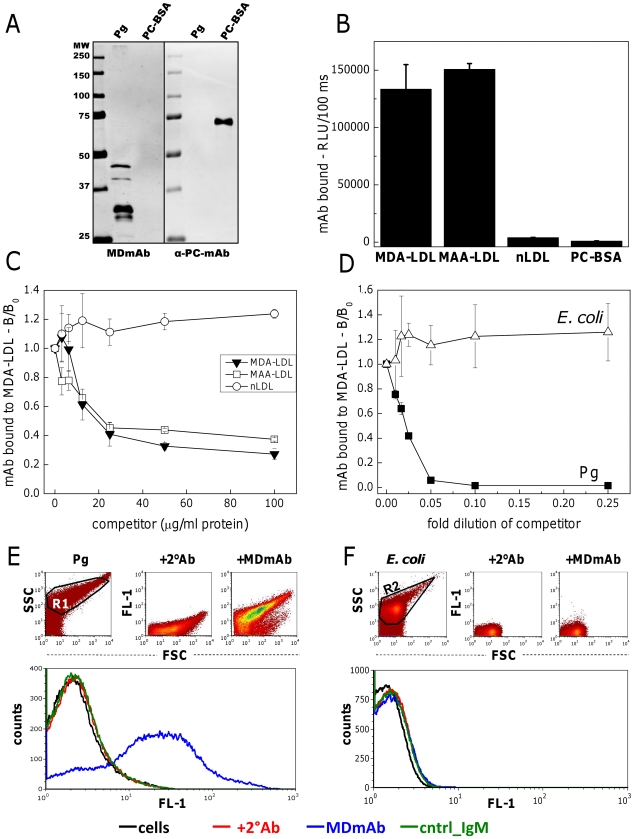
Cross-reactive epitopes on MDA-LDL and bacteria.Binding of anti-MDA-LDL-IgM (MDmAb) and anti-PC-IgM control antibody (α-PC-mAb) to P. gingivalis (Pg) and PC-conjugated bovine serum albumin (PC-BSA) on Western blot (A). Binding of MDmAb to MDA- and MAA-modified and native LDL (nLDL) and PC-BSA using direct binding (B) and competitive (C) chemiluminescence immunoassays. Specific binding of MDmAb to P. gingivalis (Pg) and E. coli was tested with competitive chemiluminescence immunoassay (D). Bacterial suspensions were adjusted to an absorbance of 0.15 at 580 nm with PBS and further diluted as indicated. B/B0 indicates the ratio of IgM binding with and without a competitor. RLU, relative light unit. Binding of MDmAb and isotype control (cntrl_IgM) to P. gingivalis (E) and E. coli (F) in native conditions was tested with flow cytometry. Fluorescence (FL-1) of the cells with the secondary antibody, +2°Ab (red), MDmAb (blue) and isotype control (green).